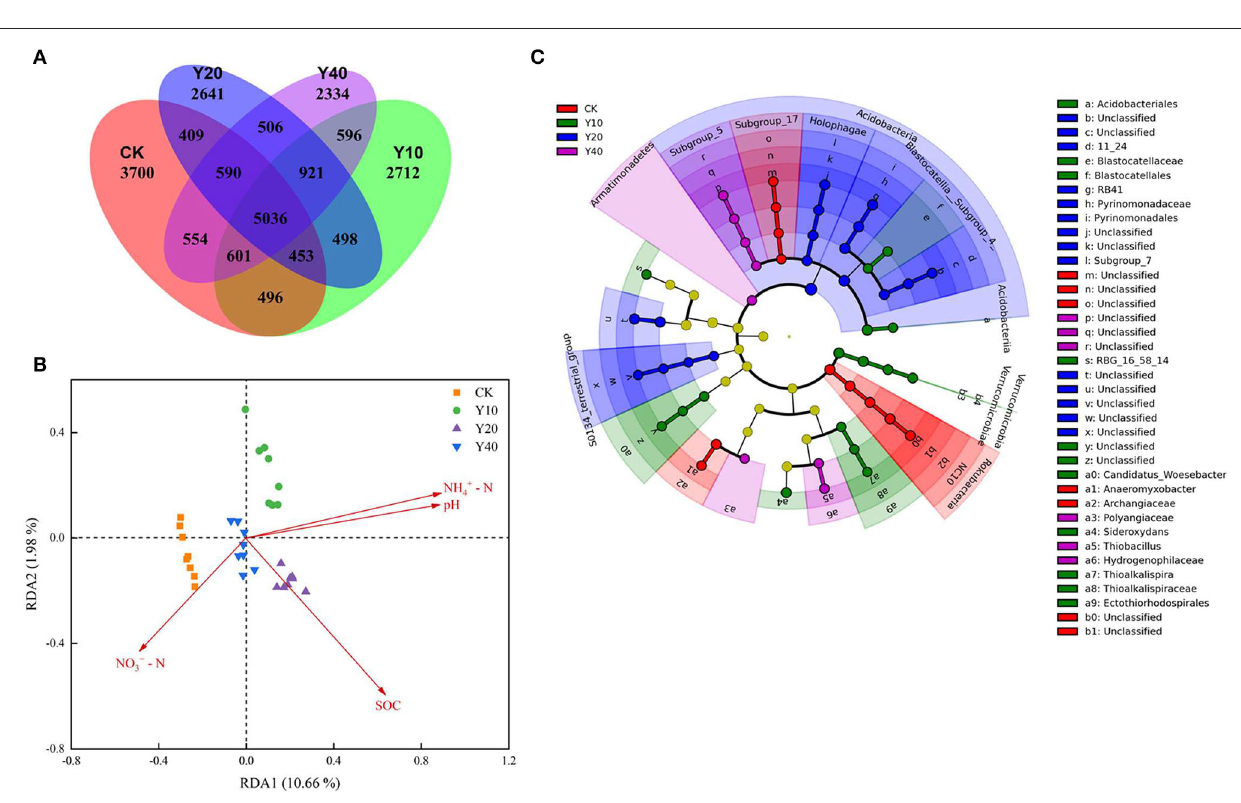
FIGURE 3 | Venn diagrams showing the shared and unique OTUs (A) and redundancy analysis shows soil properties drive the bacterial community (B) . Linear discriminant analysis Effect Size (LEfSe) identified the size of differentiation in bacterial abundances between different treatments with a threshold value of 3.0 (C) . SOC, Soil organic carbon; NH + 4 -N, Ammonia-N; NO − 3 -N,